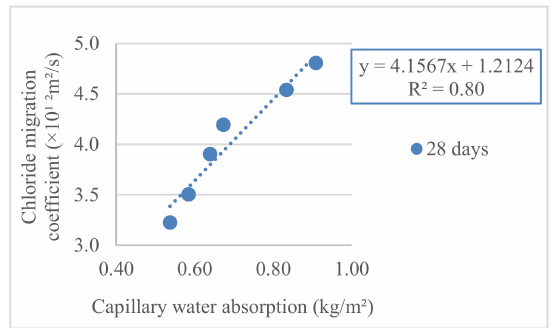
Figure 13. Relationship between chloride migration and capillary water absorption results at 28 days.